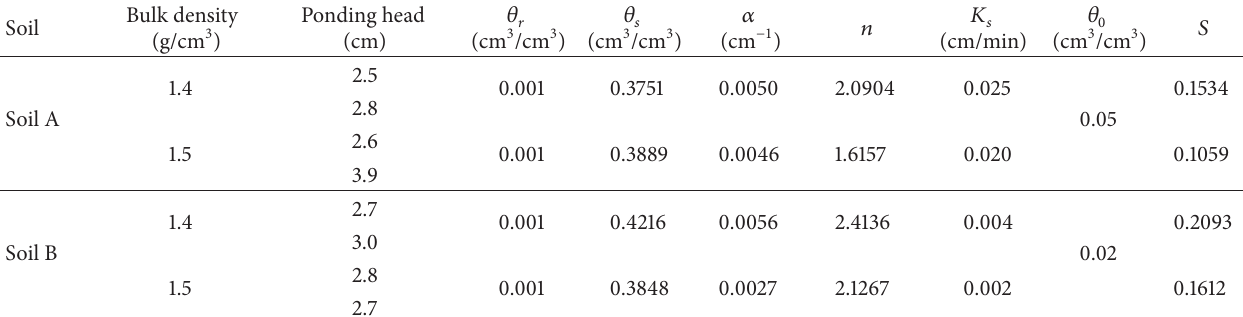
Table 2: Soil hydraulic parameters and conditions in the infiltration